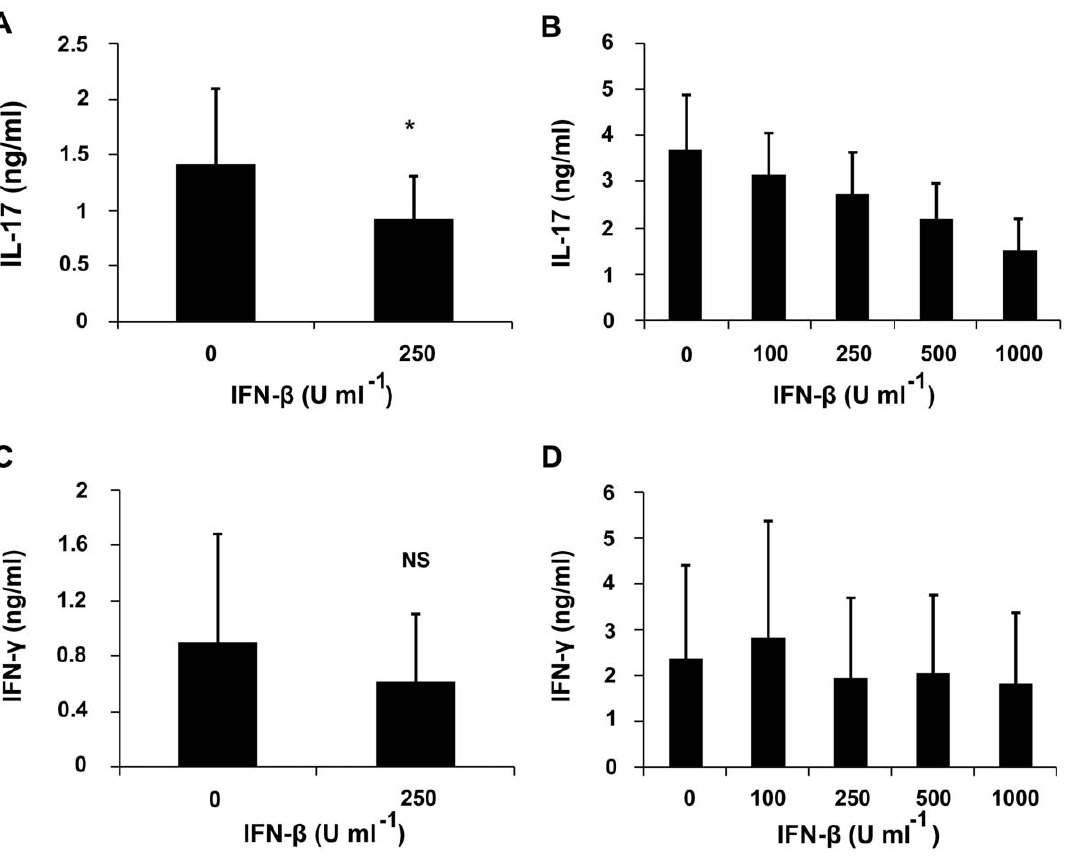
Figure 6. Effect of IFN- b -treated monocytes on the expression of IFN- c and IL-17. Naı¨ve T cells (A and B) and effector/memory T cells (C and D) were cultured with IFN- b -treated monocytes at a ratio of 5:1 for 72 hours. Cytokines were detected by ELISA. Data are representative of three independent experiments. *p , 0.05, NS=not significant.